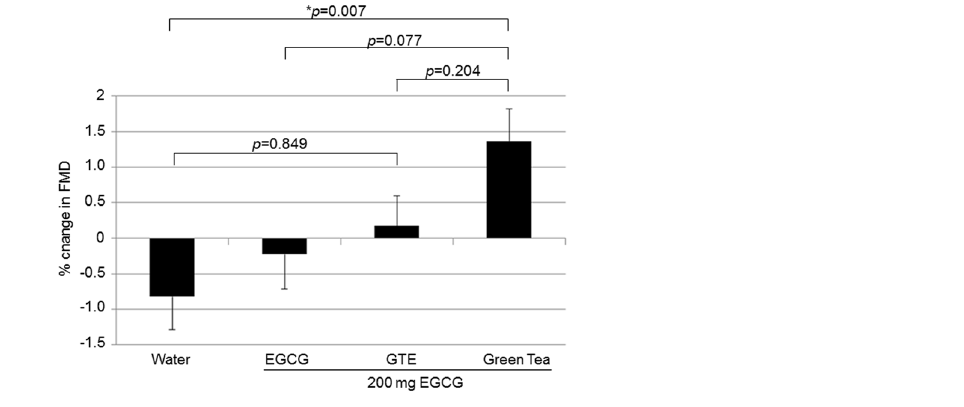
Figure 2. Only green tea increased flow-mediated dilation (FMD). Subjects consumed 200 mg of EGCG as isolated EGCG, GTE, or green tea after fasting overnight. An equal volume of hot water served as control. Green tea significantly increased FMD compared to GTE, EGCG, and water as control. Water slightly decreased FMD, whereas EGCG and GTE had little effects. Data are means ± SEM from n = 50 subjects. All p-values by repeated measures ANOVA followed by post hoc